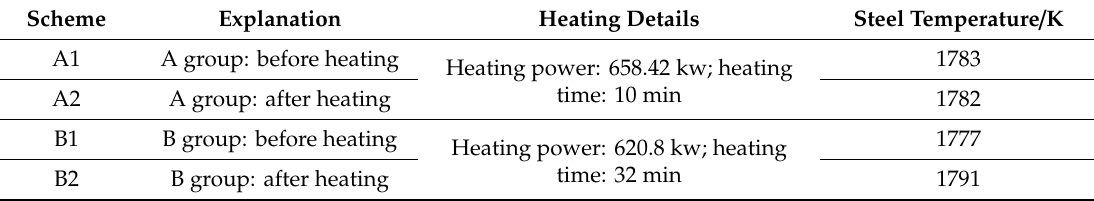
Table 2. The specific experimental details of the two groups’ heating